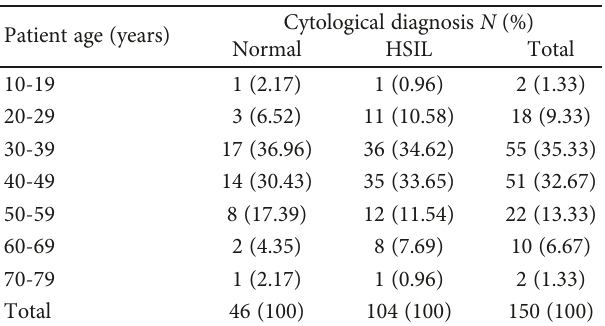
Table 1: Cytological diagnosis of clinical specimens with respect to patient